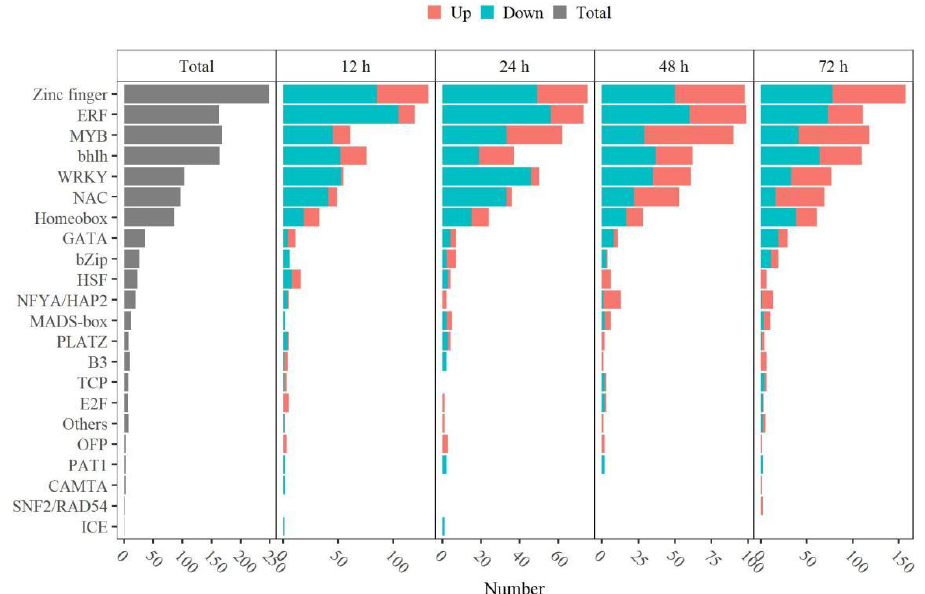
Figure 12. TDZ regulates the gene expression of transcript factors in AZ. DEGs were determined between 12 h and 0 h, 24 h and 0 h, 48 h and 0 h, 72 h and 0 h, respectively. The DEGs were controlled by FDR < 5% and |log2Fc| ≥ 1.